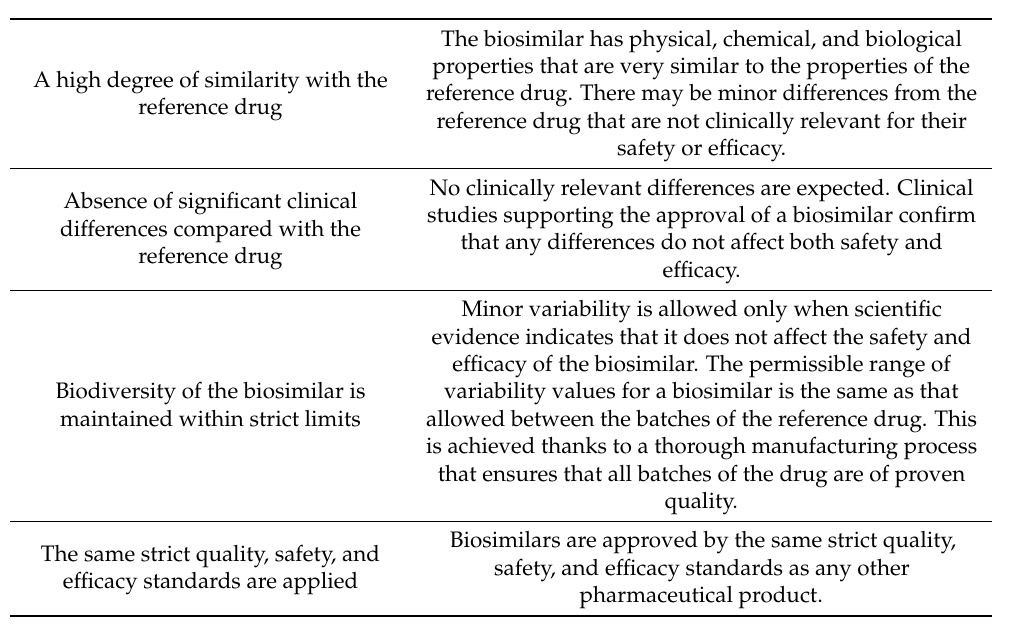
Table 1. Specific characteristics of biosimilar drugs (Amended by: Biomaterials in the EU. Information guide for health professionals: European Medicines Agency and European Commission